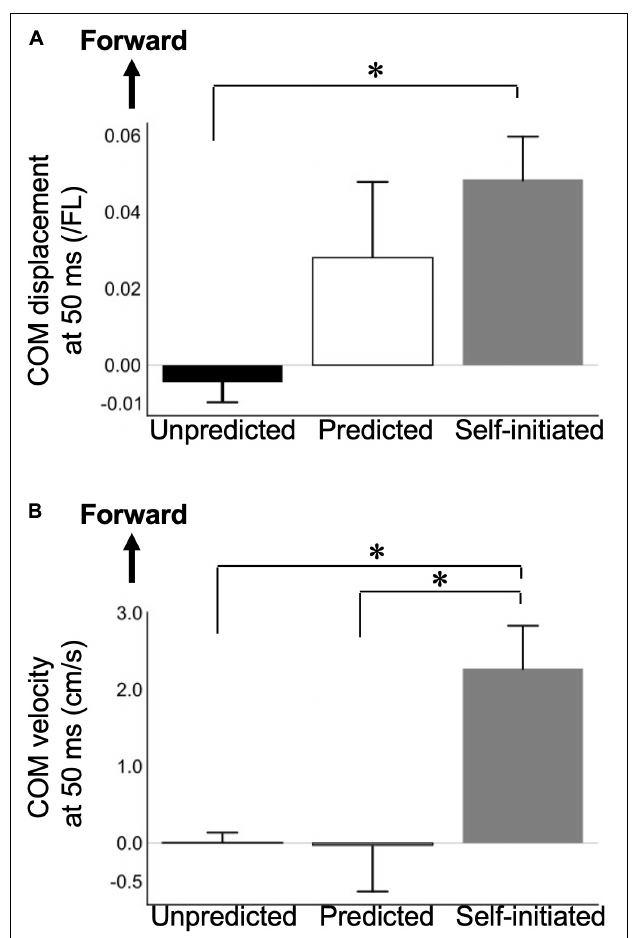
FIGURE 4 | Significant differences in the effect of step training on center of mass outcomes in the Self-initiated step training group compared to the Unpredicted and Predicted step training groups. Mean and standard error of mean plots of two COM outcomes: (A) COM displacement and (B) COM velocity at 50 ms after the perturbation. Bar plots summarize the change in each measure before versus during step training. Error bars show the standard error of mean. Positive values indicate that the COM shifted in the forward direction with respect to the COM at the initiation of perturbation, and vice versa. * p < 0.05; COM, center of mass; FL, foot length.